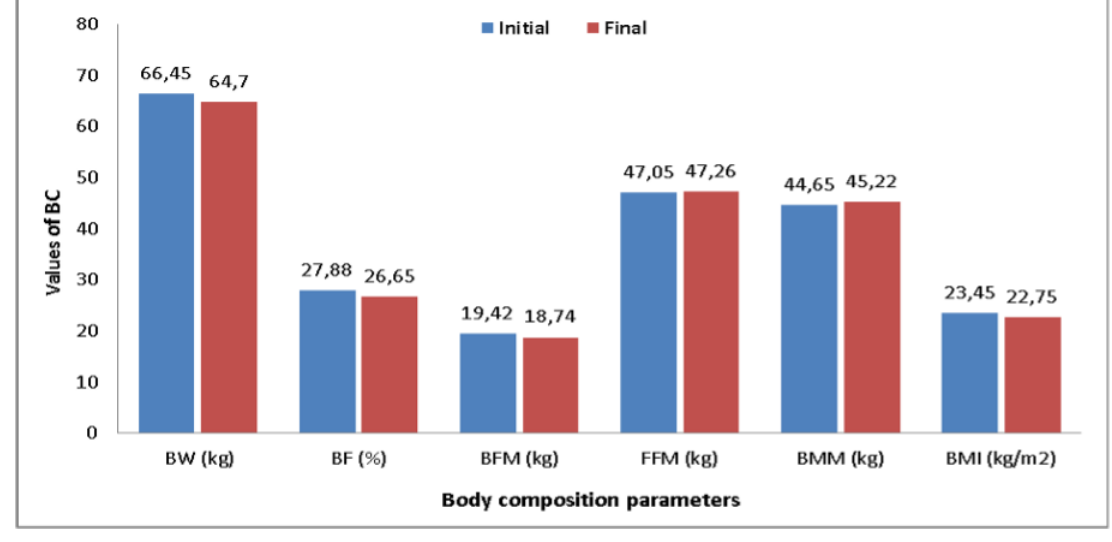
Figure 1. Differences between mean values in Body composition